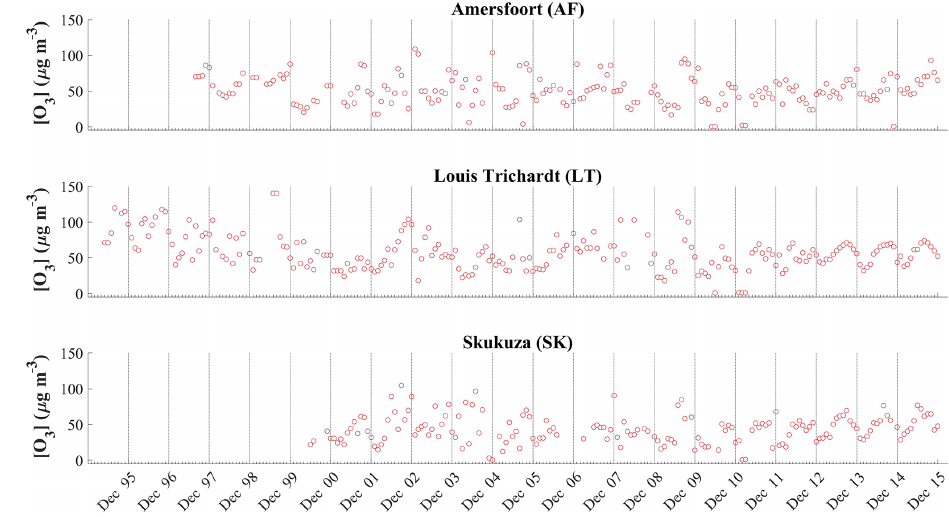
Figure A3. Time series of monthly average O 3 concentrations measured at Amersfoort (AF), Louis Trichardt (LT) and Skukuza (SK) using passive samplers over the relevant measurement periods.